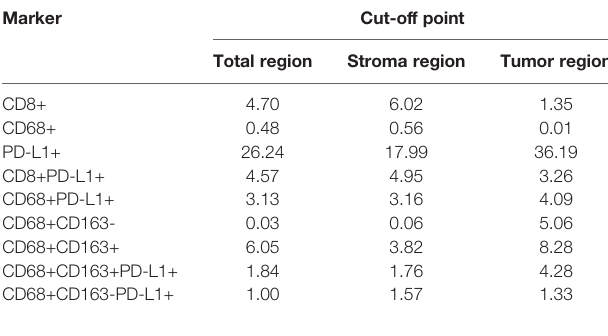
TABLE 2 | Cut-off points of all markers according to PFS.